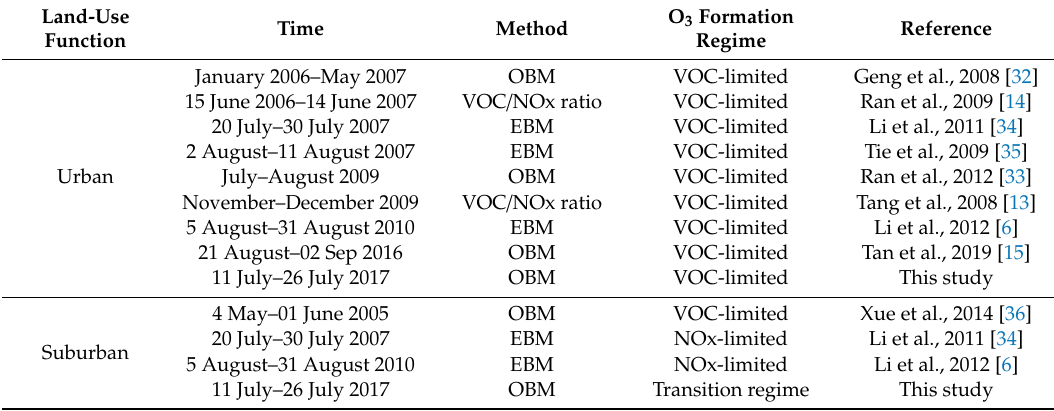
O 3 Formation Regime